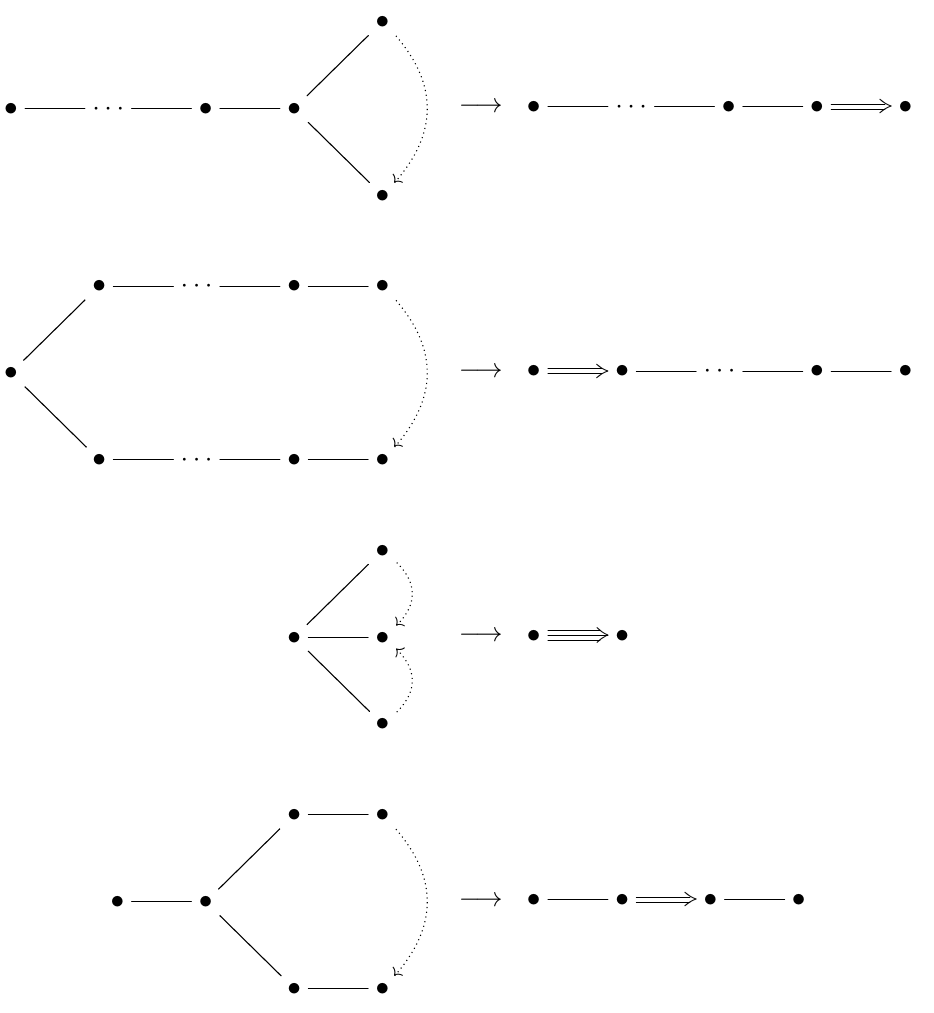
Figure 9. Dynkin diagram